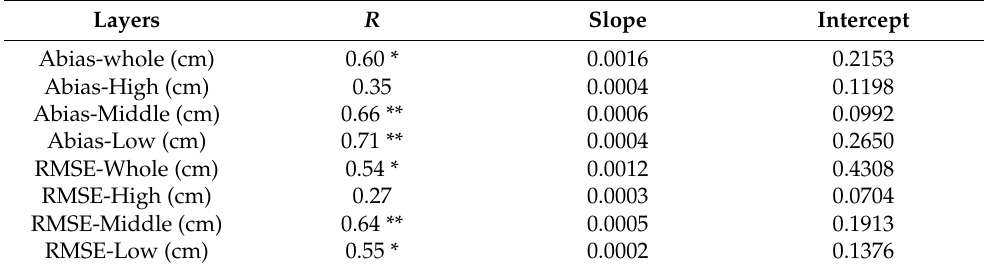
Table 2. The R , slope, and intercept between Abias, RMSE, and RDLS. Layers R Slope Intercept Abias-whole (cm) 0.60 * 0.0016 0.2153 Abias-High (cm) 0.35 0.0004 0.1198 Abias-Middle (cm) 0.66 **